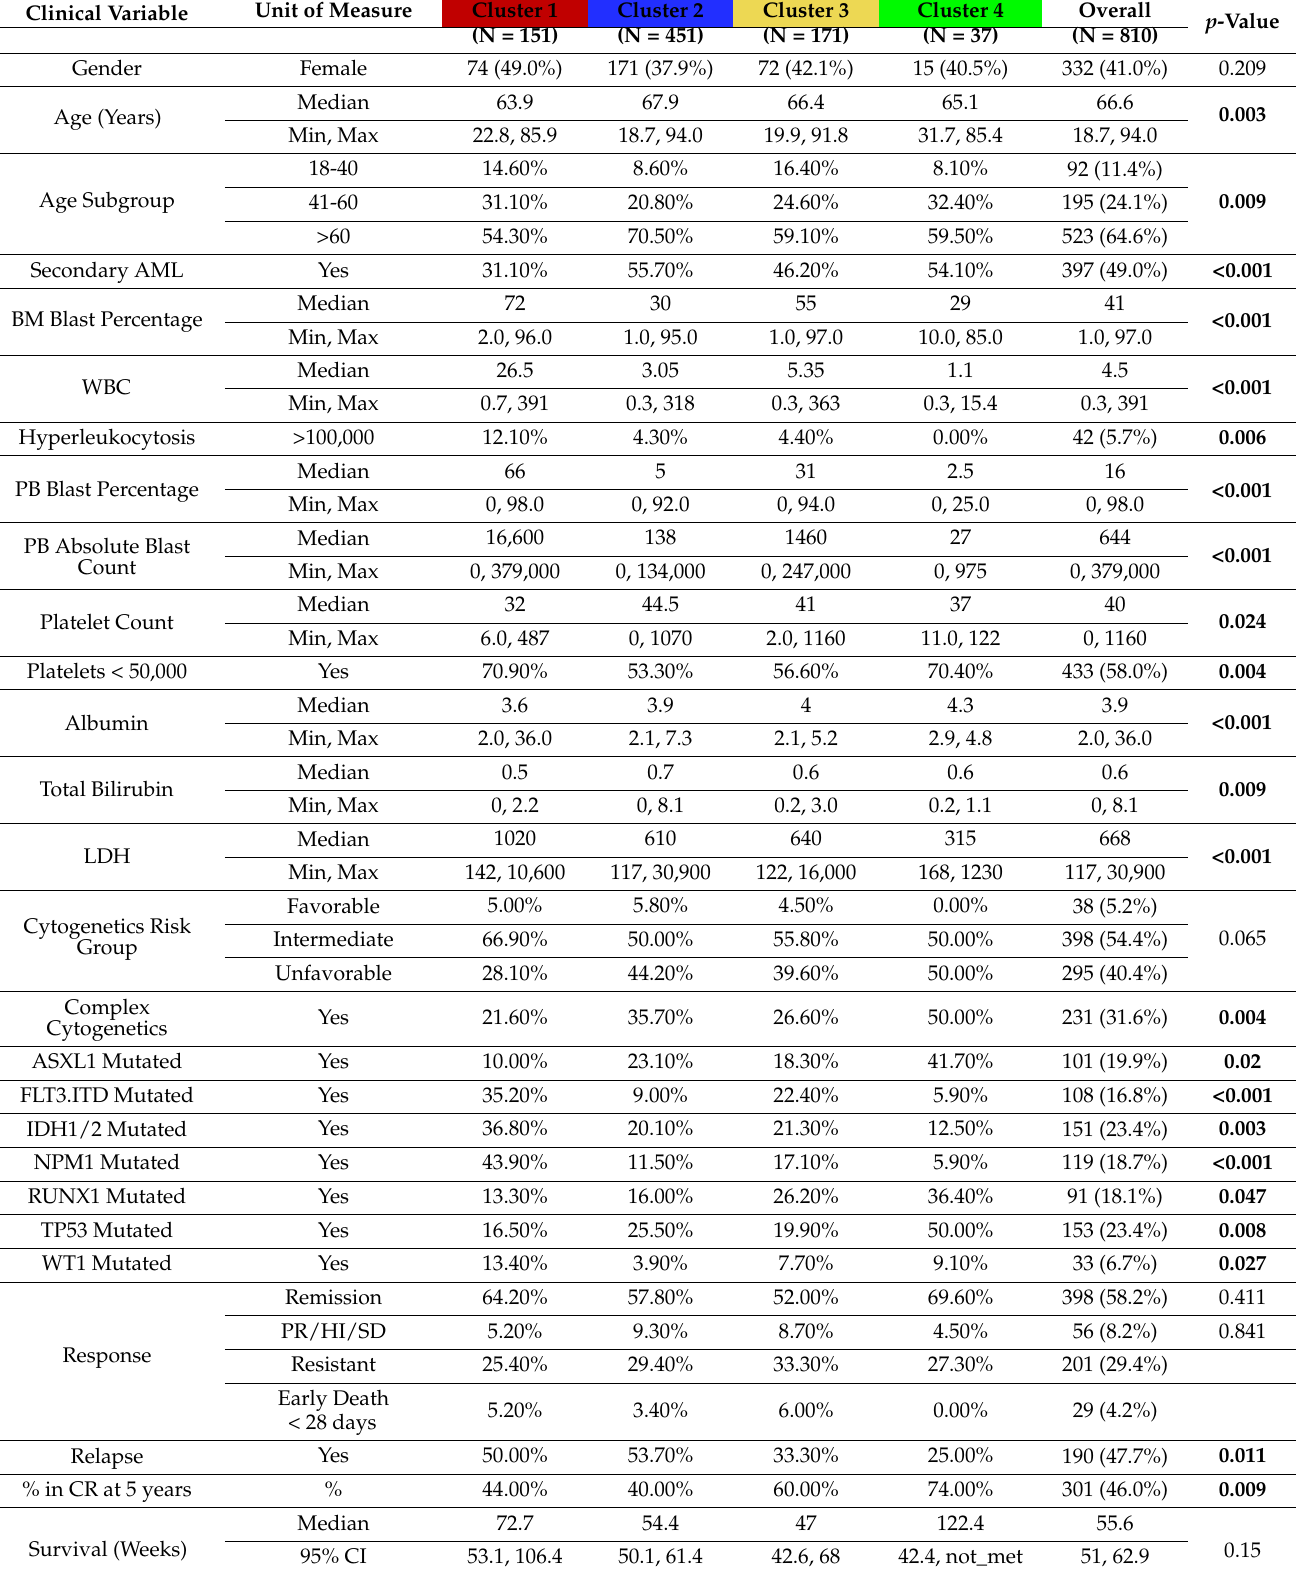
Table 2. Adult AML demographics and clinical information corresponding to Figure 1